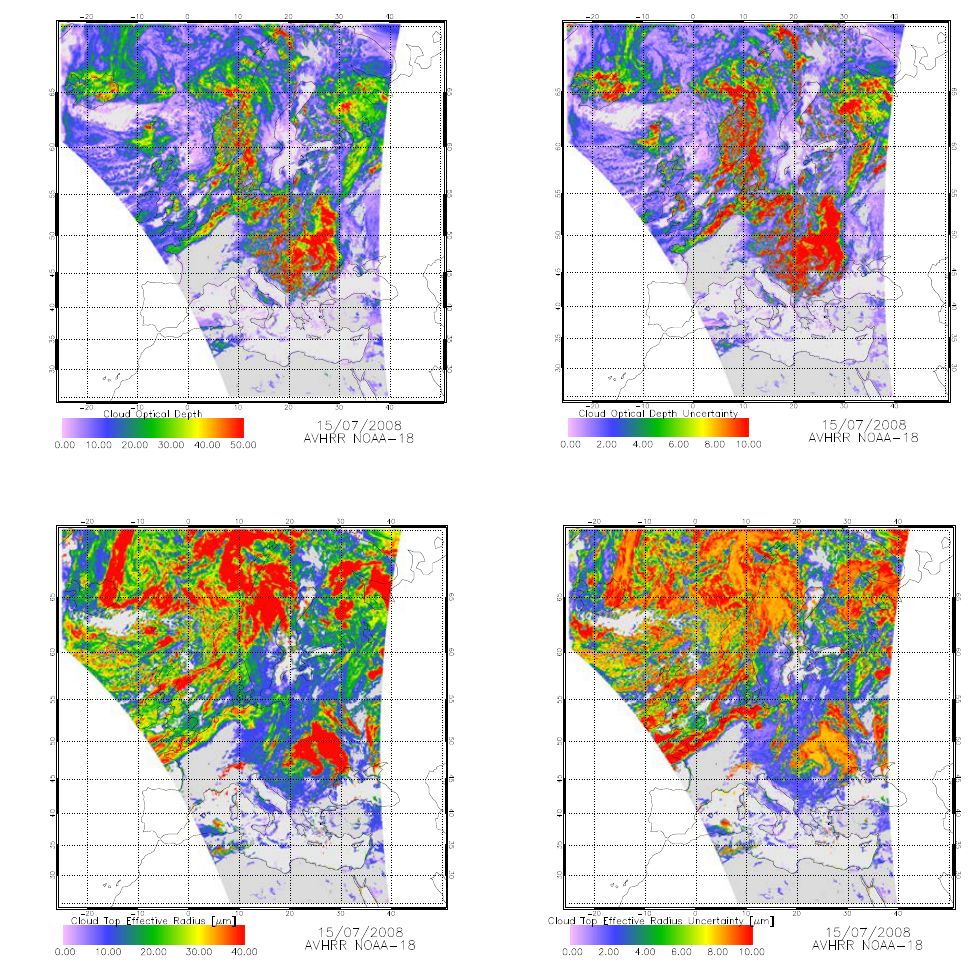
Figure 6. Cloud optical depth (top row) and effective radius (bottom row) retrieval results (left) and associated uncertainties (right) for the same data as in Fig.